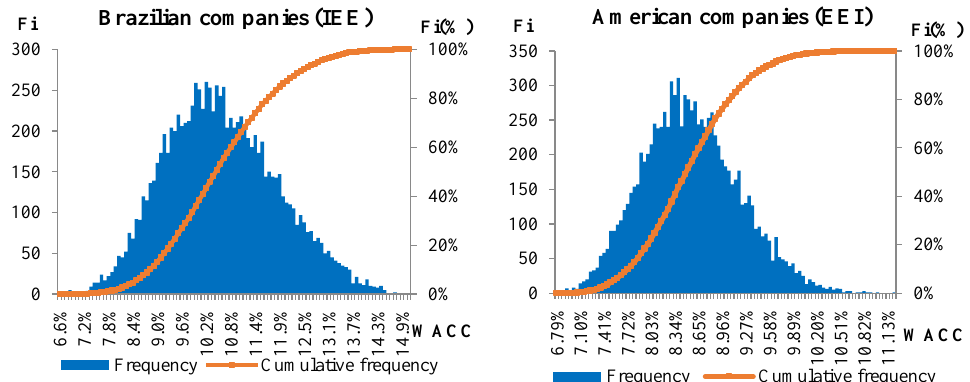
Figure 3. Histogram of the frequency and cumulative frequency (%) of the Monte Carlo simulation from the perspective of the Brazilian (IEE) and American (EEI) companies. Table 5. Descriptive statistics of the output variables of the WACC projection from the perspective of IEE and EEI companies.